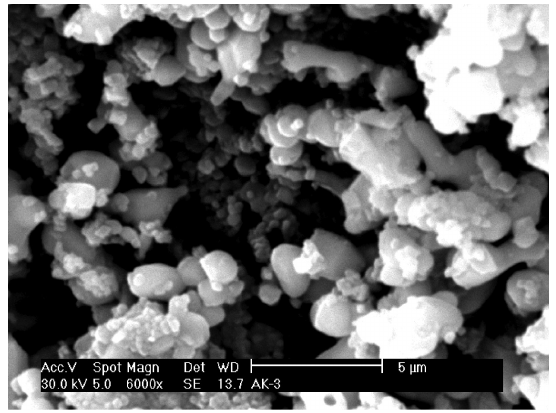
Fig. 4: Typical scale morphology on the surface of Inconel 617 at 1000 °C